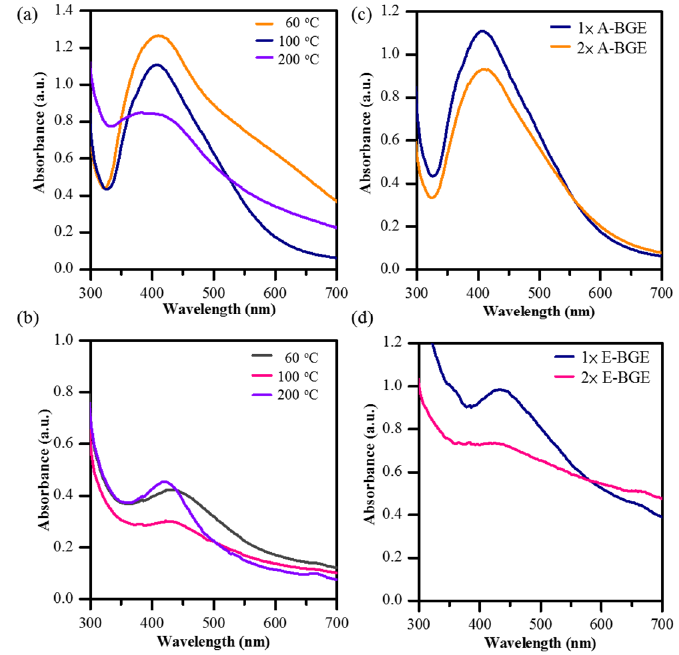
Figure 1. UV–vis spectra of purified A-BG-AgNPs and E-BG-AgNPs prepared at different ( a , b ) reaction temperatures and ( c , d ) BGE concentrations.